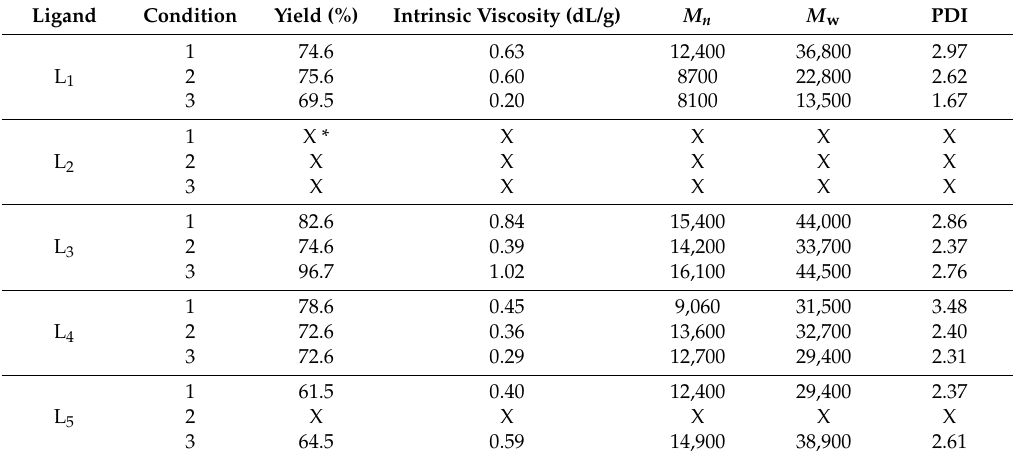
Table 5. Effects of ligand and polymerization condition on molecular weight of PPE.